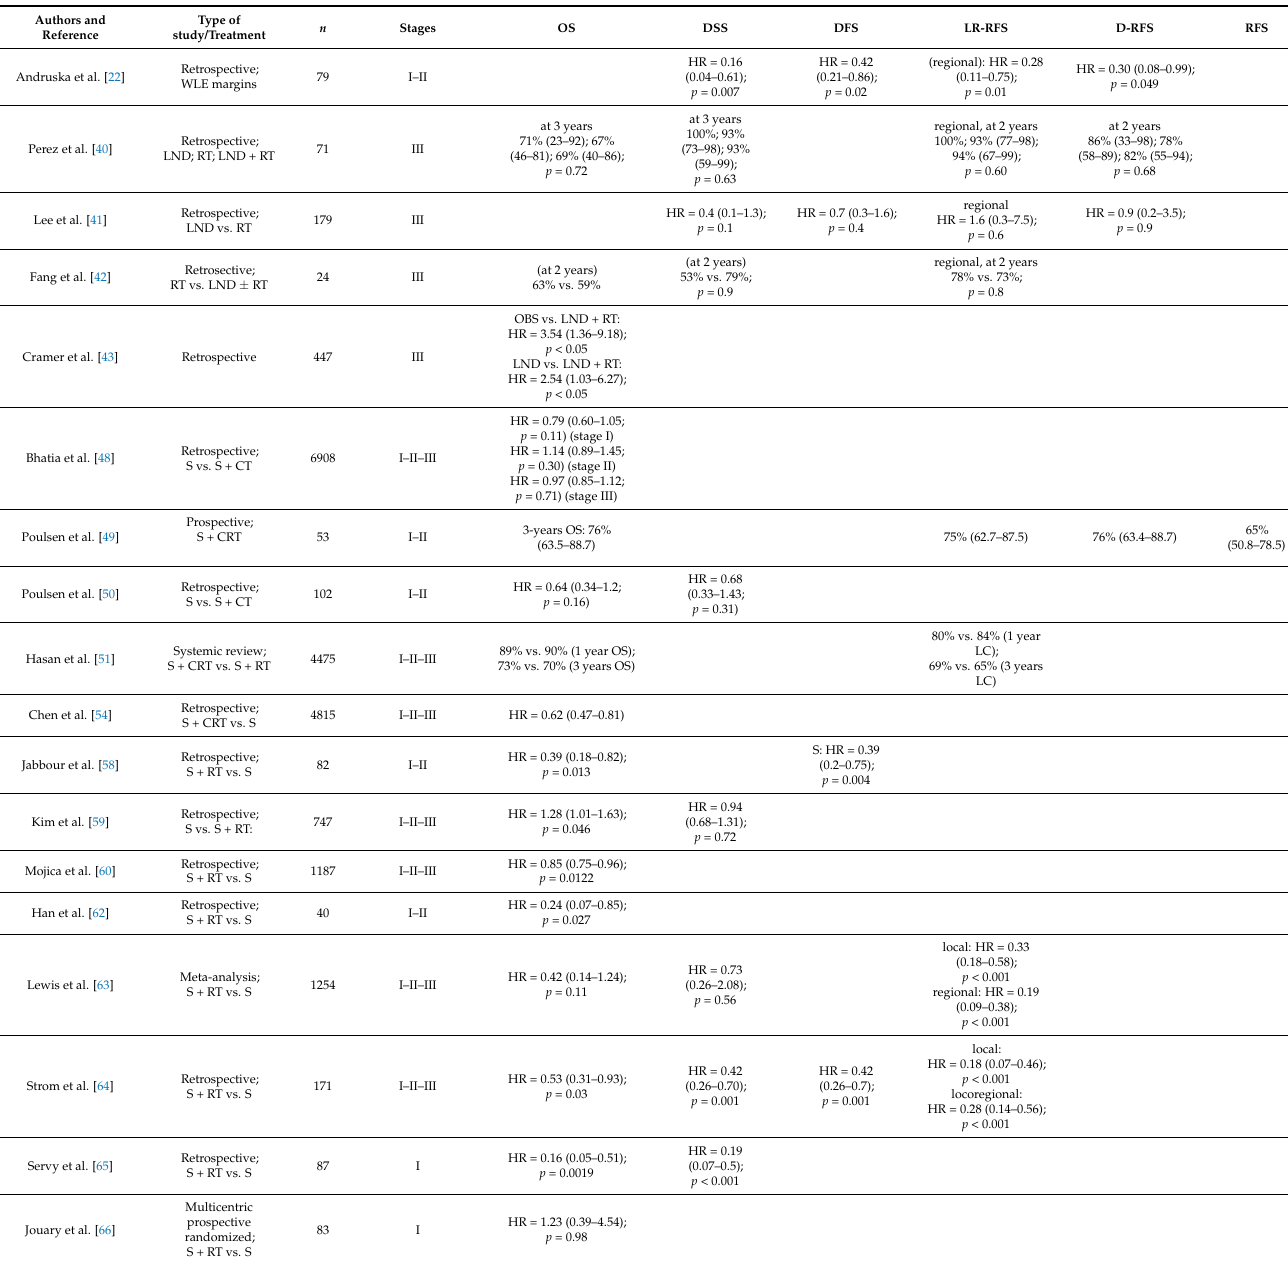
Table 1. Summary of available data in the management of non-metastatic Merkel cell